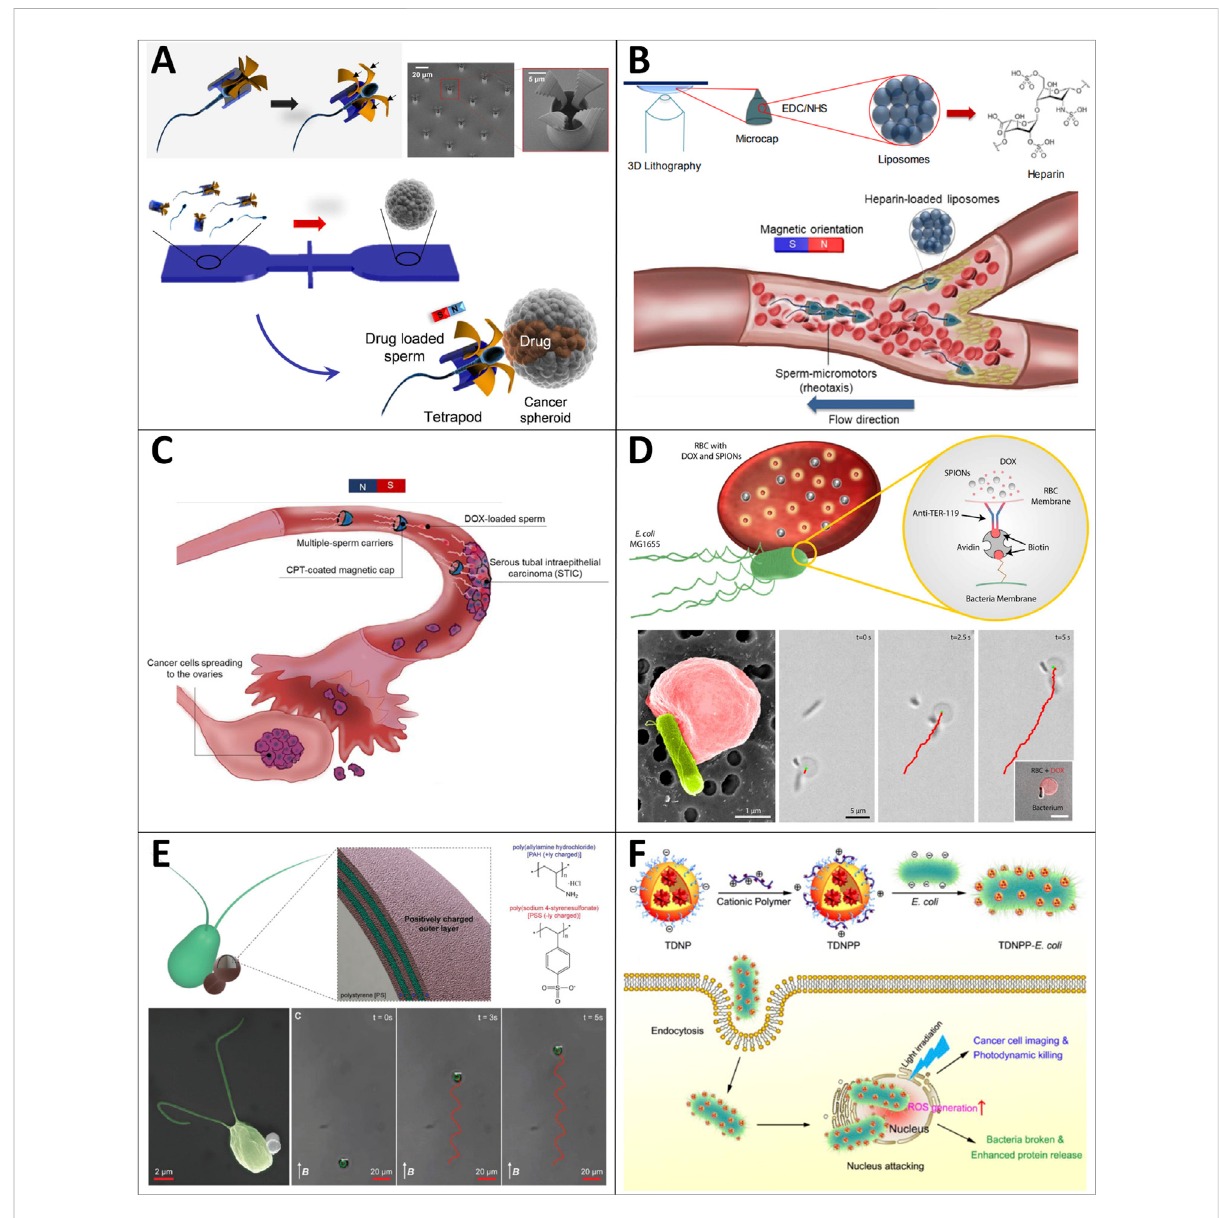
FIGURE 9 Motile drug delivery by biohybrid MNRs. (A) Sperm hybrid micromotors. (Xu et al., 2018) Copyright 2018. Reproduced with permission from American Chemical Society. (B) Streamlined-horned cap (SHC) hybrid sperm micromotors. (Xu et al., 2020a) Copyright 2020. Reproduced with permission from American Chemical Society. (C) Human-sperm based hybrid micromotors. (Xu et al., 2020b) Copyright 2020. Reproduced with permission from The Royal Society of Chemistry. (D) Soft erythrocyte-based bacterial microswimmers. (Alapan et al., 2018) Copyright 2018. Reproduced with permission from American Association for the Advancement of Science. (E) Microalga-powered biohybrid microswimmers. (Yasa et al., 2018) Copyright 2018. Reproduced with permission from John Wiley and Sons. (F) Poly-ethylenimine aggregation-induced emission photosensitizer nanoparticles (TDNPP)-coated E. coli . (Wu M et al., 2019) Copyright 2019. Reproduced with permission from American Chemical